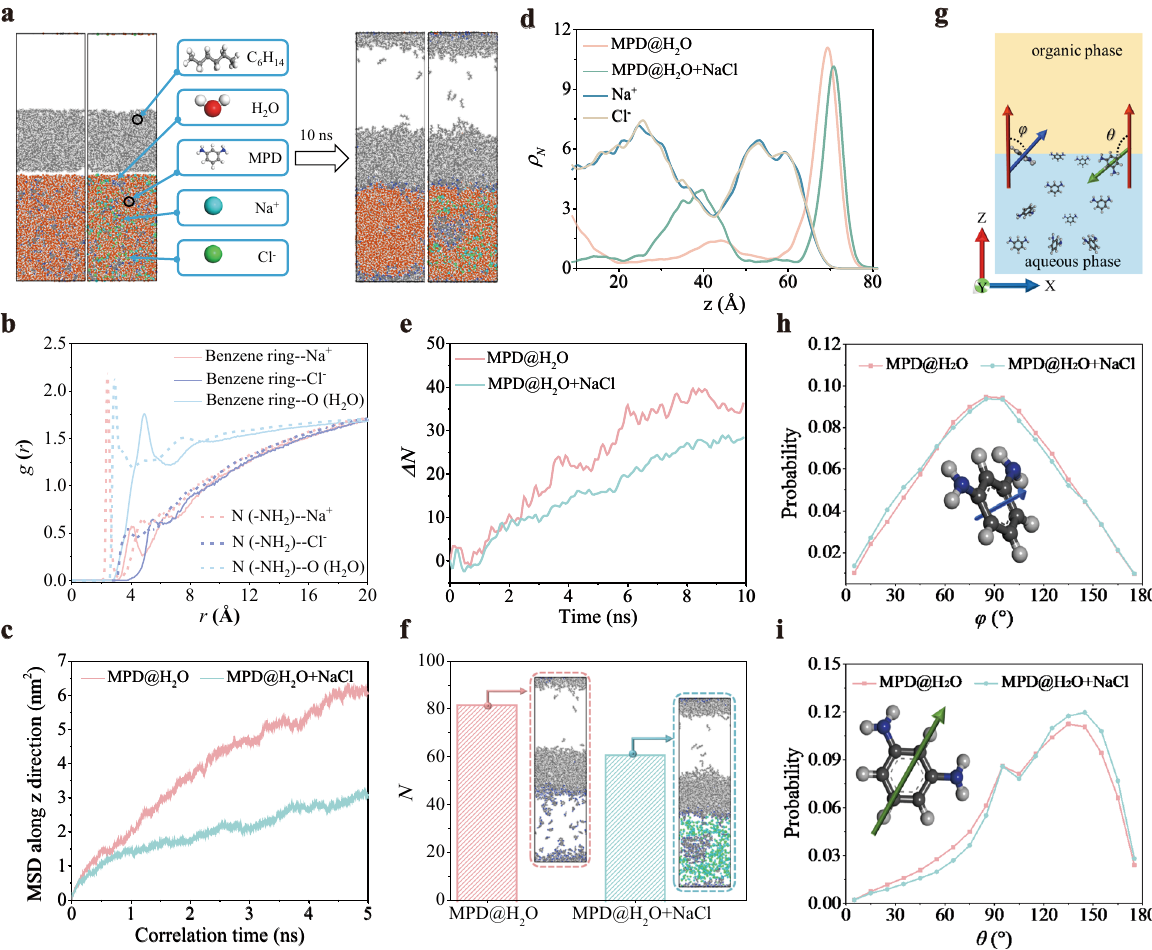
Fig. 3 MD Simulation results. a The initial (0 ns) and fi nal (10 ns) snapshots of two systems with (right) and without (left) NaCl, respectively. b Radial distribution function of pairs MPD-H 2 O and MPD-NaCl: pairs of benzene ring – Na + (red solid line), benzene ring – Cl − (blue solid line), benzene ring – O (green solid line), N – Na + (red dot line), N – Cl − (blue dot line) and N – O (green dot line). c The MSD pro fi les of MPD molecules in two systems with and without NaCl, respectively. d The number density ( ρ N ) distribution of MPD molecules (green and red lines), Na + (blue line), and Cl − (yellow line) ions in the two systems with and without NaCl, respectively. e The increased number variation of MPD molecules ( Δ N = N − N 0 ) compared with the initial value ( N 0 ) and f the eventual number ( N ) of MPD at the interface of the two systems with and without NaCl, respectively. g Schematic diagram of the angles ( φ and θ ) formed between the positive direction of z-axis (red arrow, aqueous phase points to the organic phase) and the vectors perpendicular (blue) and parallel (green) to the benzene ring of MPD molecules. (h) The probability distribution of the angle ( φ ) formed between the positive direction of the z-axis and the vector perpendicular to the benzene ring of MPD at the interface of the systems with and without NaCl, respectively. i The probability distribution of the angle ( θ ) formed between the positive direction of the z axis and the vector parallel to the benzene ring of MPD at the interface of the systems with and without NaCl,